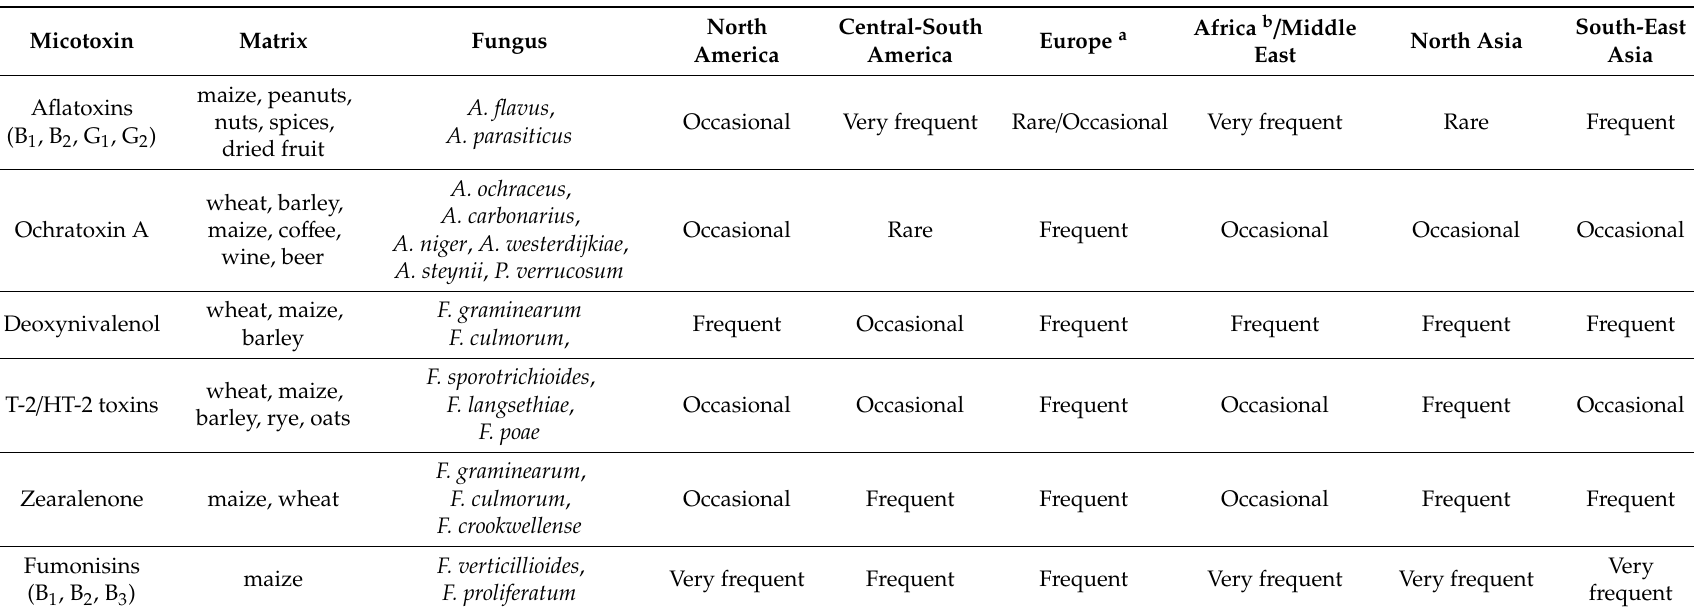
Table 1. Mycotoxins of major concern occurring in food / feed, relevant fungal producers and geographical areas a ff